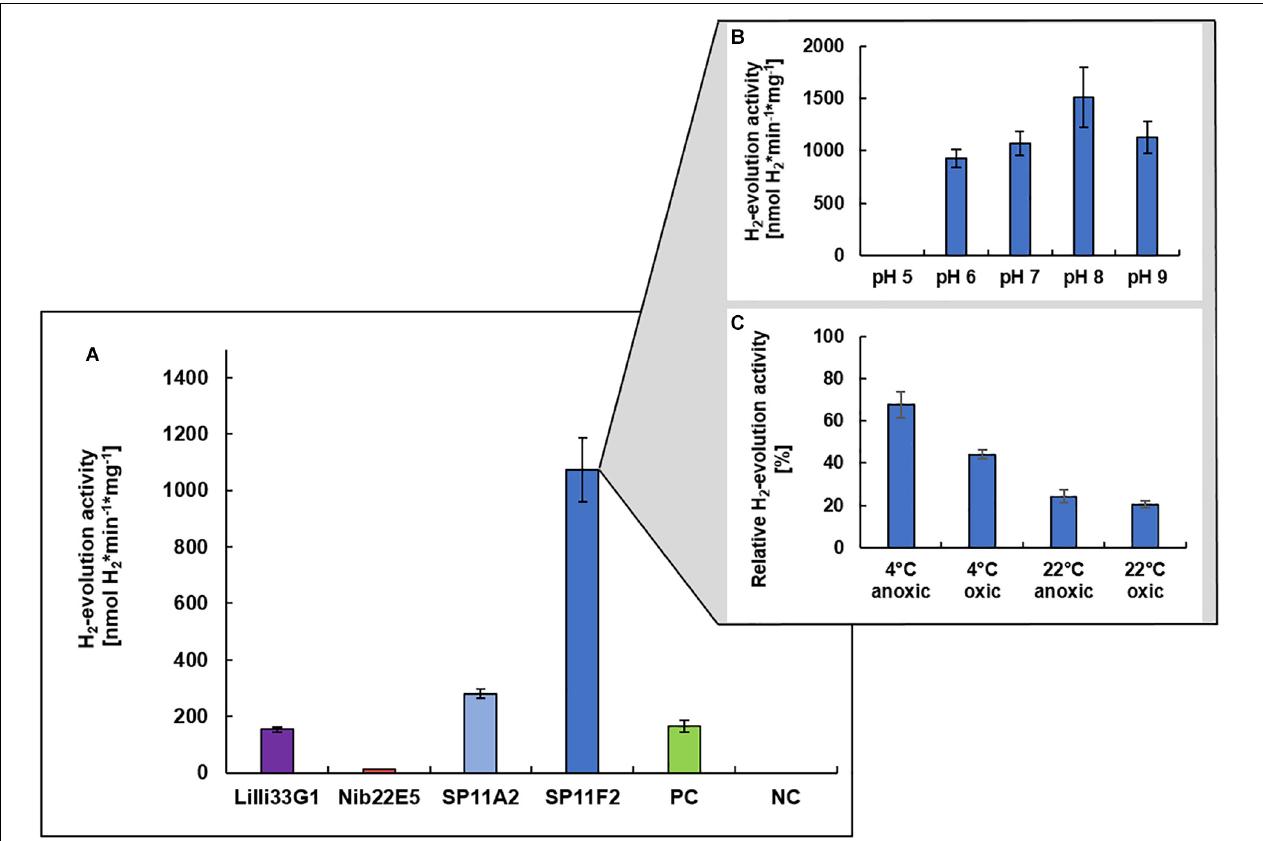
FIGURE 2 | H 2 -evolution activities of recombinant hydrogen converting enzymes. Specific H 2 -evolution activities of the membrane fractions of four metagenomic clones (measured at pH 7.0) are shown (A) . The respective metagenomic DNA was derived from three different hydrothermal vent systems from the Mid-Atlantic Ridge: (i) the Lilliput system (Lilli33G1, marked in purple), (ii) the Nibelungen system (Nib22E5, marked in red), and (iii) the Sisters Peak vent (SP11A2 and SP11F2, marked in blue). The positive control (marked in green) is the membrane fraction of clone P5H2 (harboring the recombinant S. oneidensis wild type hydrogenase) and the negative control is the membrane fraction of S. oneidensis (cid:49) hyaB harboring the empty pRS44 vector, which is used for the heterologous expression of (meta-) genomic inserts. The pH optimum of SP11F2 is shown in (B) and the stability of SP11F2 at pH 7 under different storage conditions (for 24 h) has been tested (C) . Anoxic conditions refer to an atmosphere of 97% N 2 and 3% H 2 , oxic conditions to ambient air (21% O 2 ) and the relative activities refer to the original measurement of 1073 nmol H 2 *min − 1 *mg − 1 , displayed in panel (A) . n = 3 for all